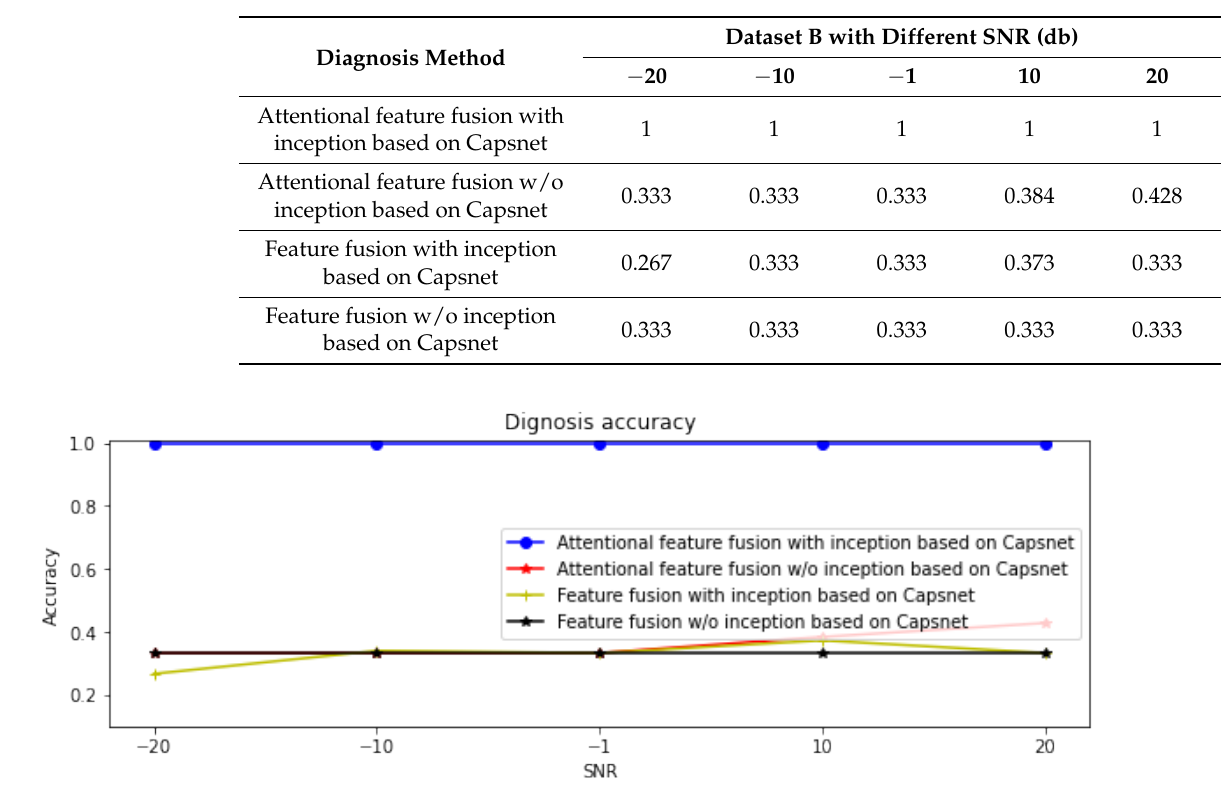
Figure 11. Diagnosis accuracy of four different feature fusion methods on different SNR datasets.